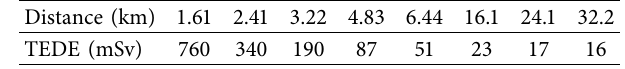
Table 1: Estimated TEDE with distance